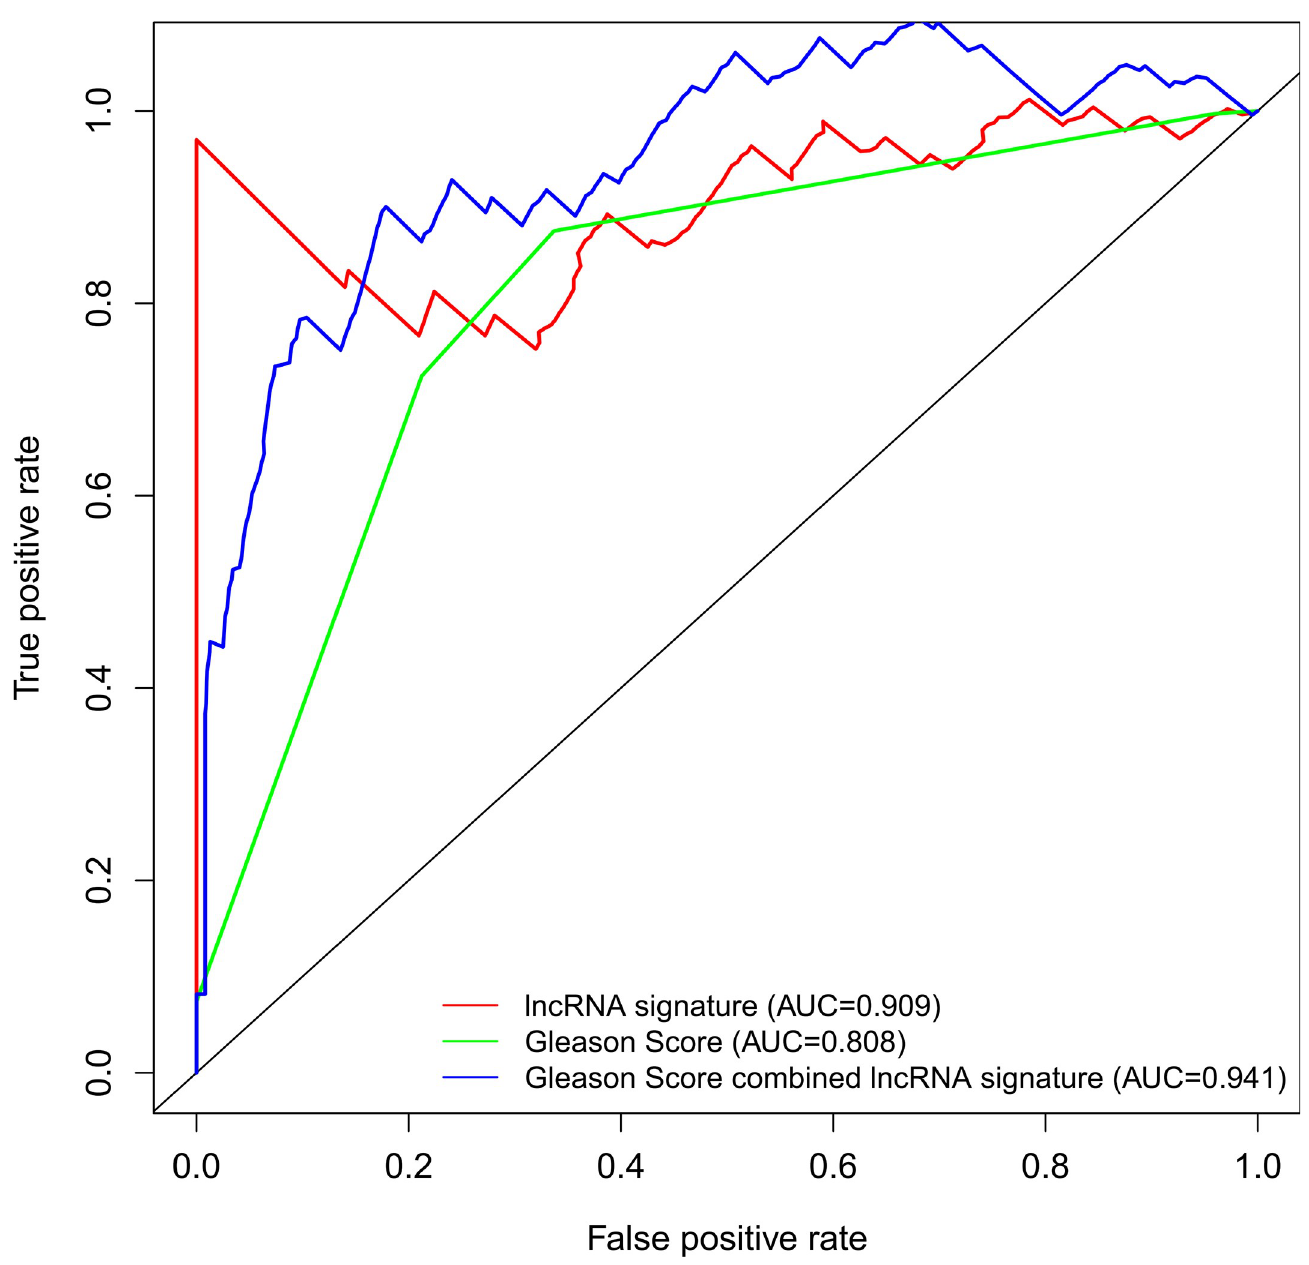
Fig 15. ICGC ROC curves for the prediction of the 3 years Overall survival among the 4-lncRNA signature model, Gleason score and our lncRNA nomogram combined with Gleason score.